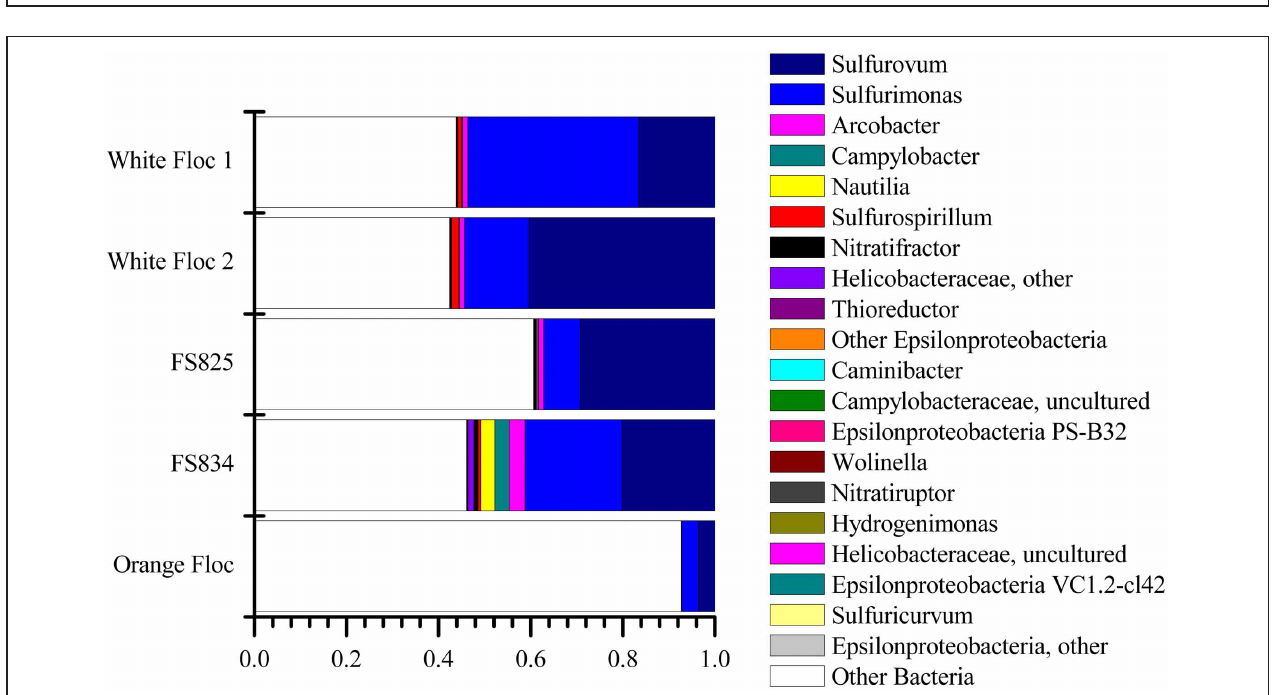
FIGURE 5 | Relative abundance of Epsilonproteobacterial genera in Illumina amplicon libraries from white floc and fluid samples from active snowblower vents as well as orange floc from the surrounding seafloor.